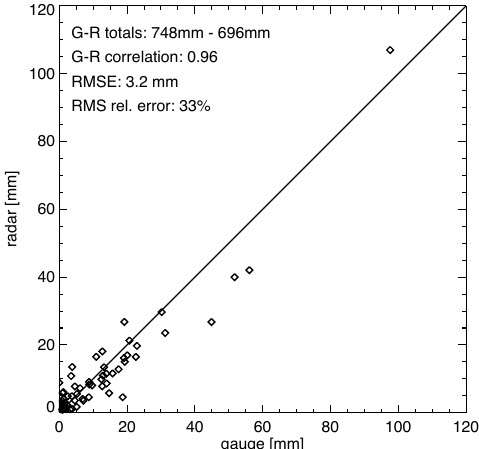
Figure 12. Scatterplot of 24h accumulations recorded with the Senet rain gauge (located in the Rebaixader catchment) and the Creu del Vent radar in the period from 1 May to 31 October